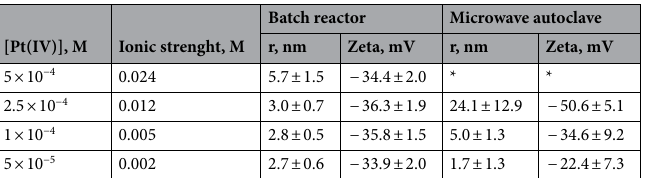
Table 2. Radius and Zeta potential of PtNPs obtained at tenfold excess of TCS. *The colloid was not obtained.